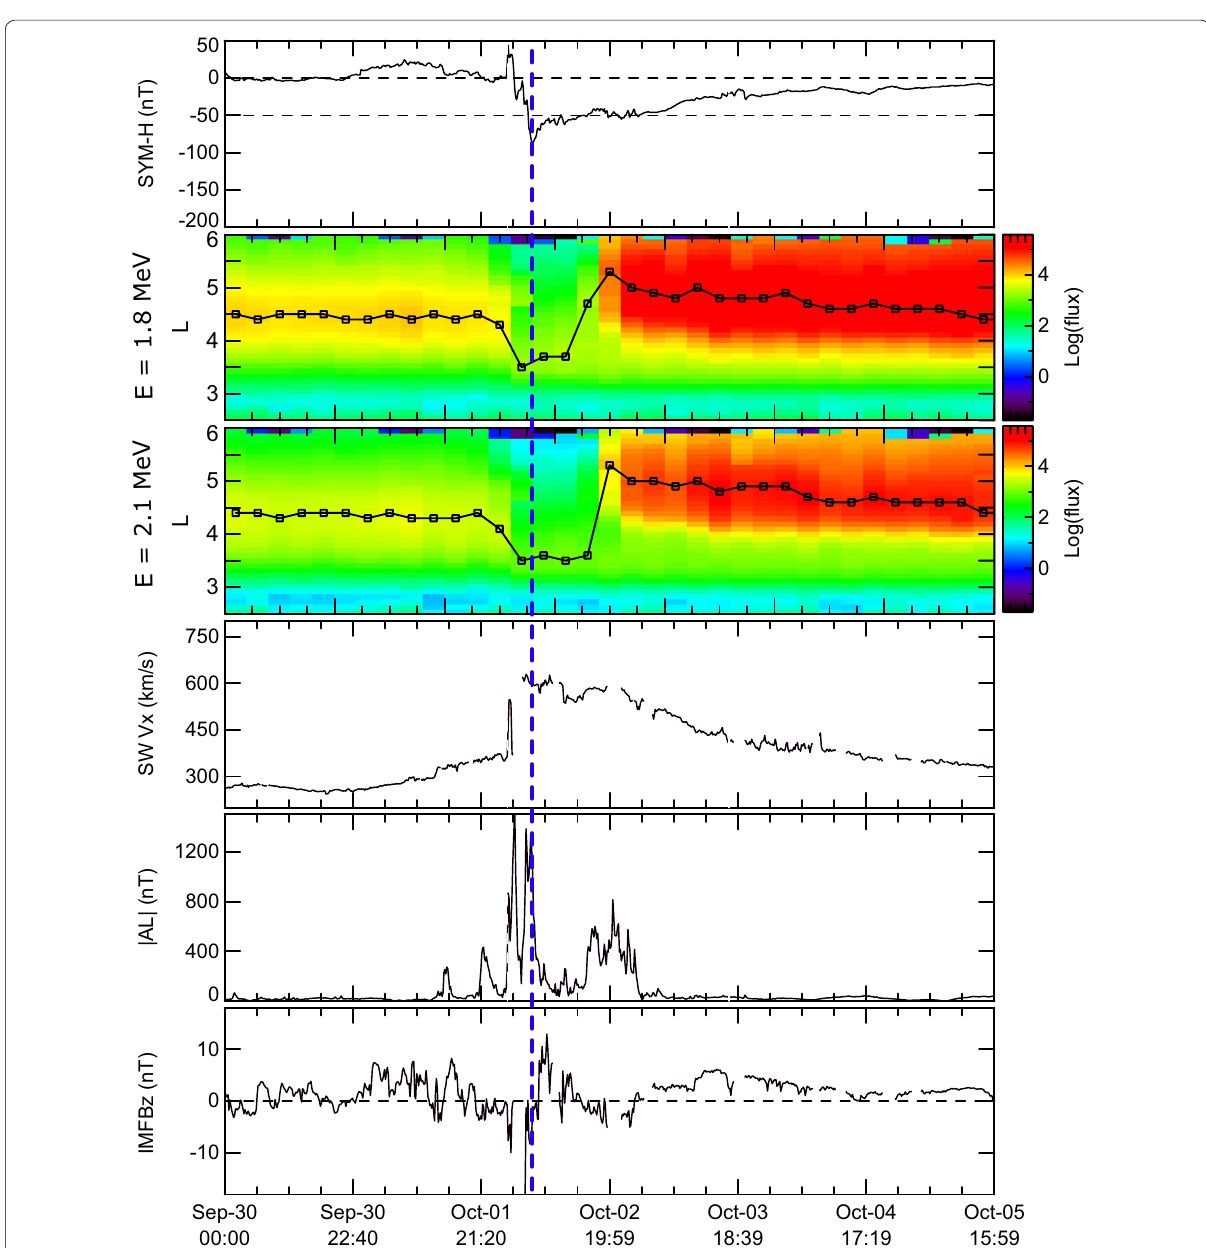
Fig. 1 From top to bottom: a the SYM-H index; b , c the differential omnidirectional fluxes of 1.8 and 2.1 MeV electrons binned at 0.1 L every 4 h, respectively; d the solar wind speed |Vx| component; e the AE index; and f the IMF Bz component in GSM observed during 1 October 2013 geomagnetic storms when the increase in ORB fluxes is